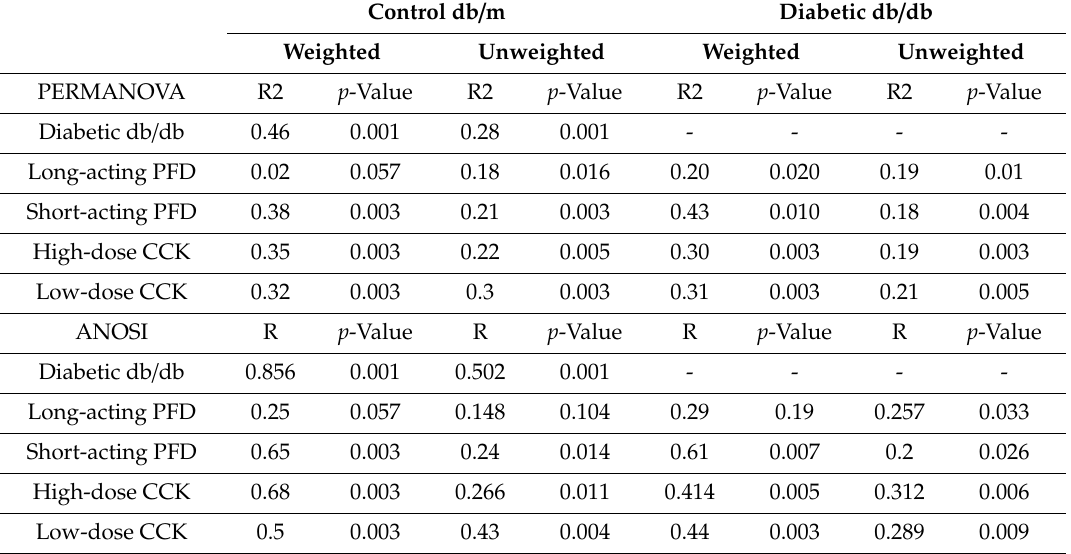
Table 1. PERMANOVA and ANOSIM test results between control db / m and diabetic db / db as well as four treatment groups using weighted and unweighted approaches with the Bray–Curtis distance